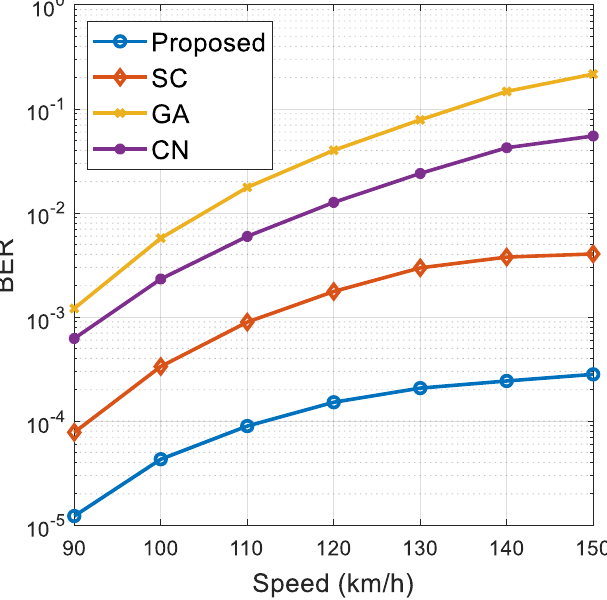
Figure 5. Multi-user scheduling simulation results when M = 2 and N t = 128. ( a ) BER of all the algorithms; ( b ) Spectral efficiency performance of all the algorithms.